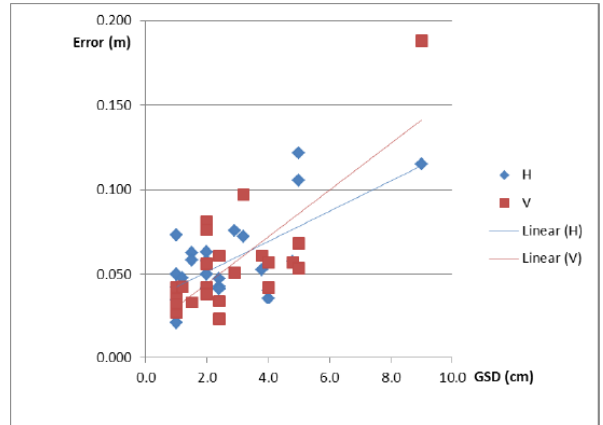
Figure 4: Horizontal and vertical RMSE in meters (vertical axis) for different GSDs in cm (horizontal axis). H = horizontal, V = vertical.